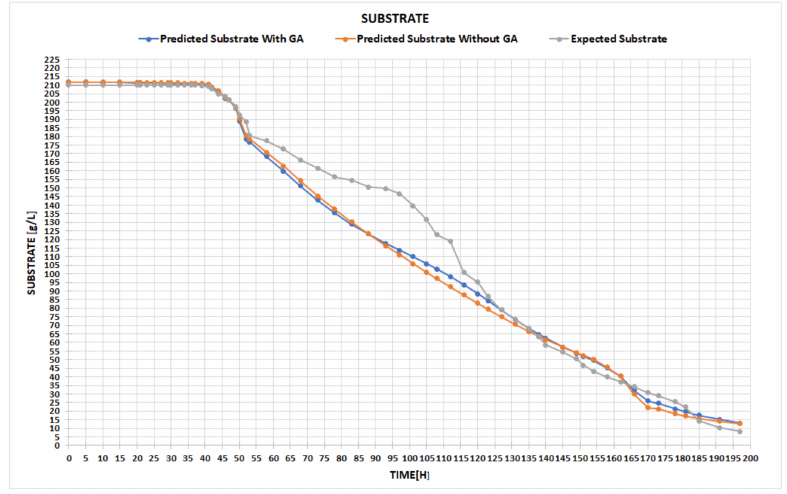
Figure 11. Substrate prediction, based on different types of weights